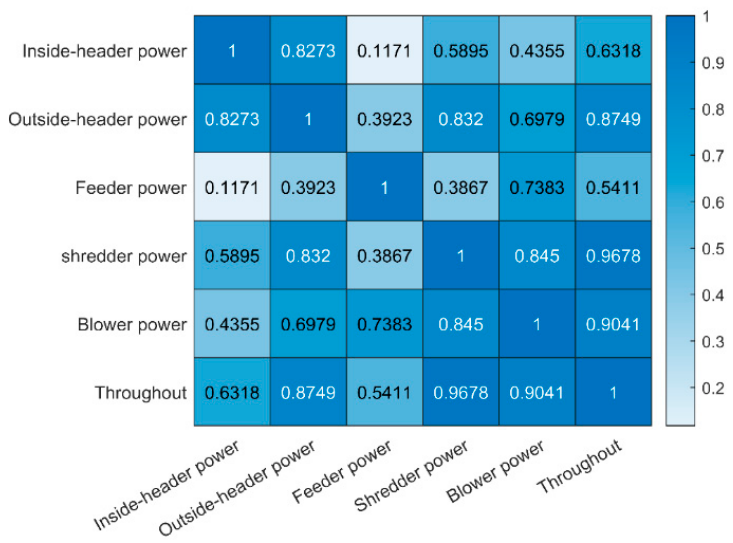
Figure 7. Heatmap of the variable correlation coefficient.